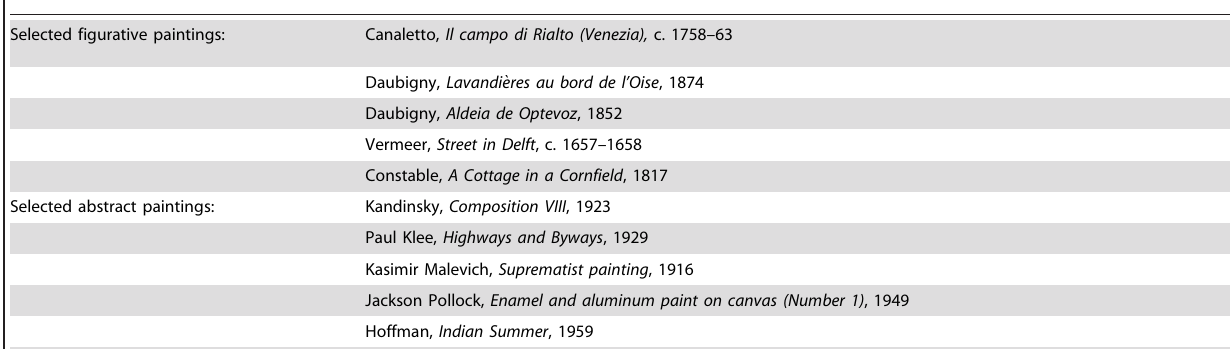
Table 1. Selected paintings for the study.